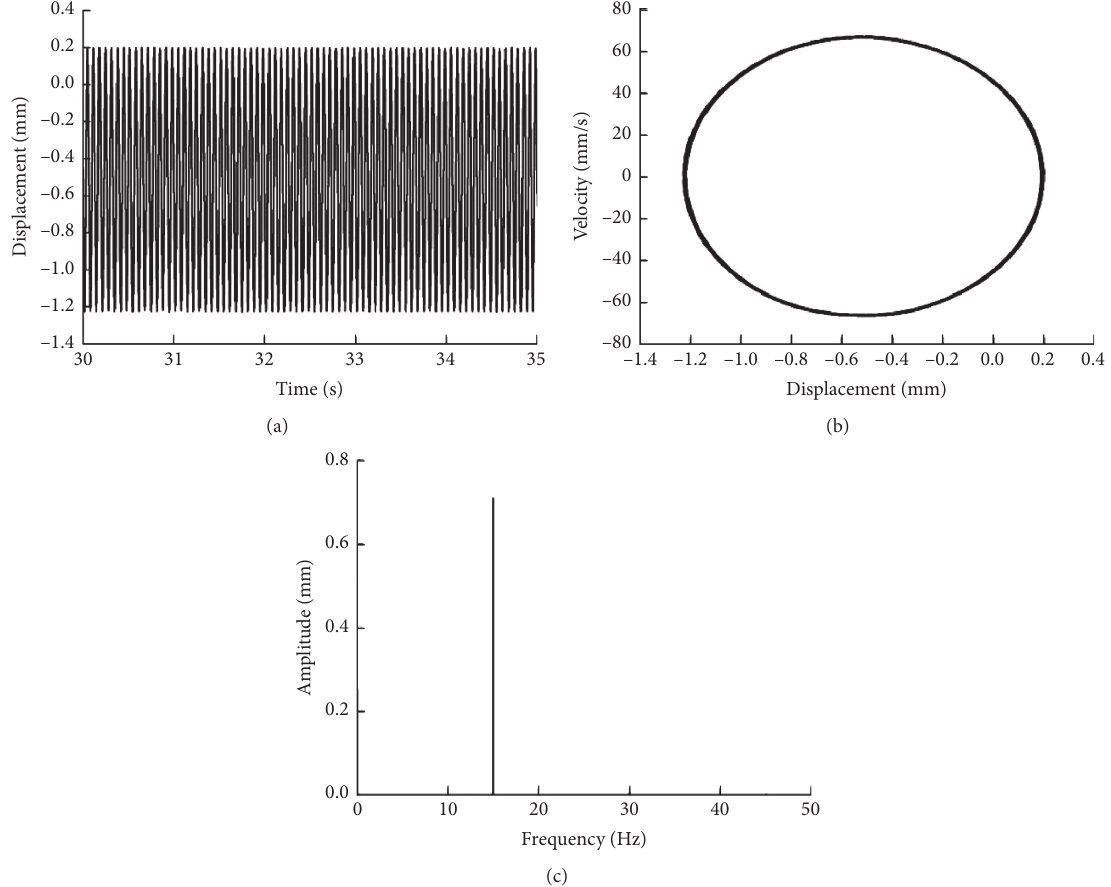
Figure 14: Period-1 motion of the structure A is obtained for the external excitation amplitude W � 2 . 5V and the external excitation frequency Ω � 15Hz: (a) waveform; (b) phase portrait; (c) amplitude